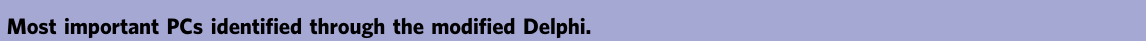
Table 2 Most important PCs identi fi ed through the modi fi ed Delphi. Challenge criteria with